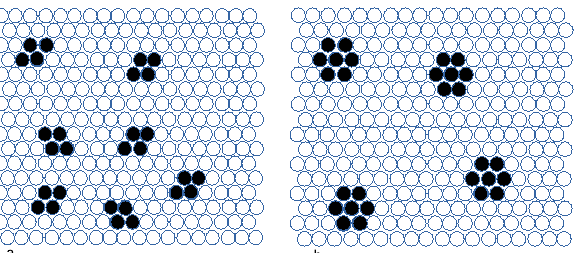
Figure 3. Representative configurations of 28 particles minimizing the energy for the repulsion-to- attraction ratio J > 13/12 ( a ) and J < 13/12 ( b ). Empty and filled circles represent empty and occupied cells of the triangular lattice. See the main text for more details.